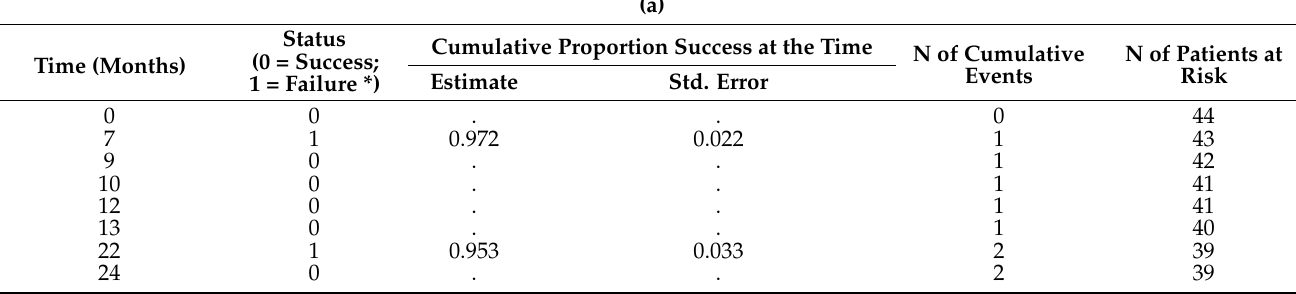
Figure 5. Zygomatic implant classification levels (ZICL) at 1- and 2-years of follow-up. The ZICL 1 level is considered the better prognostic considering the preventive aspect of a biological complication, with absence of MSEE > 4 mm, while a ZICL 4 is considered the worst prognostic level from a preventive point of view, with the presence of MSEE > 4 mm and simultaneous presence of plaque and bleeding. The sample was distributed along the two ZICL levels, with an increase of 1% in zygomatic implants with ZICL 4 level from the first to the second year of follow-up (18% to 19%). Table 5. (a) Study implants and study abutments success in complete edentulous rehabilitations using the patient as unit of analysis (Kaplan-Meyer product limit estimator). Life tables for cumulative success rate of the study zygomatic implants and study abutments of 45 and 60 degrees using the implants/abutments as unit of analysis. (a)